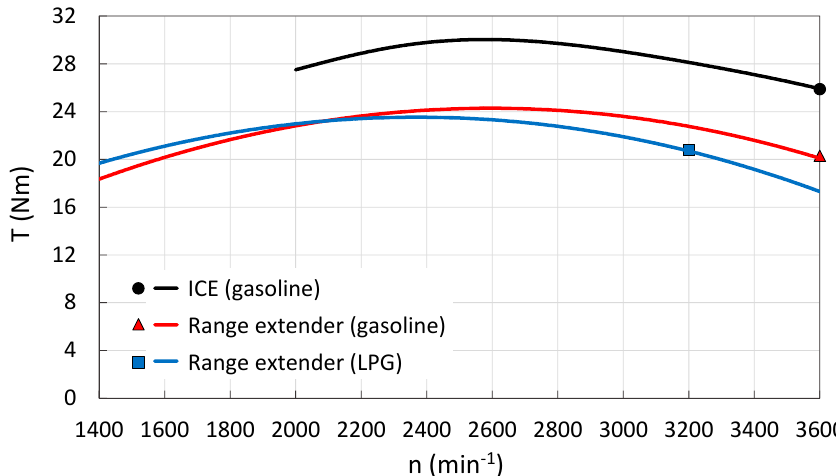
Figure 12. Torque curves at full load for the ICE (according to the manufacturer) and range extender (own testing results). The marked points correspond to the maximum power.